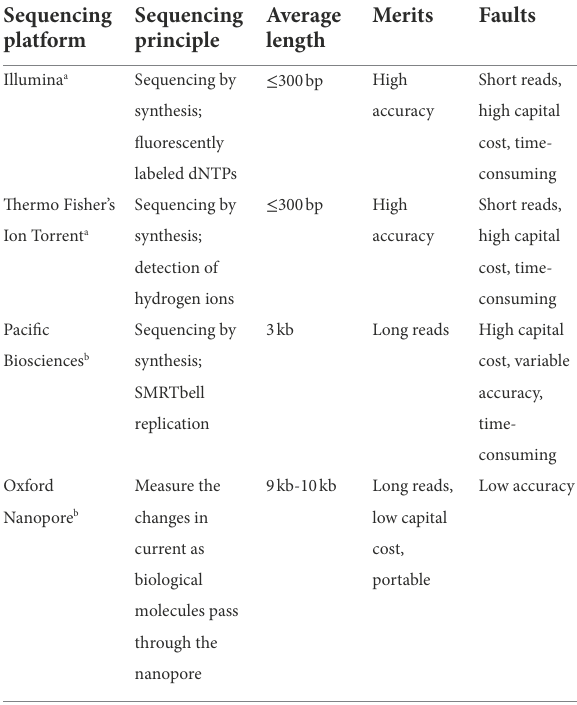
TABLE 1 Comparison of the performance of four high-throughput sequencing platforms. Sequencing